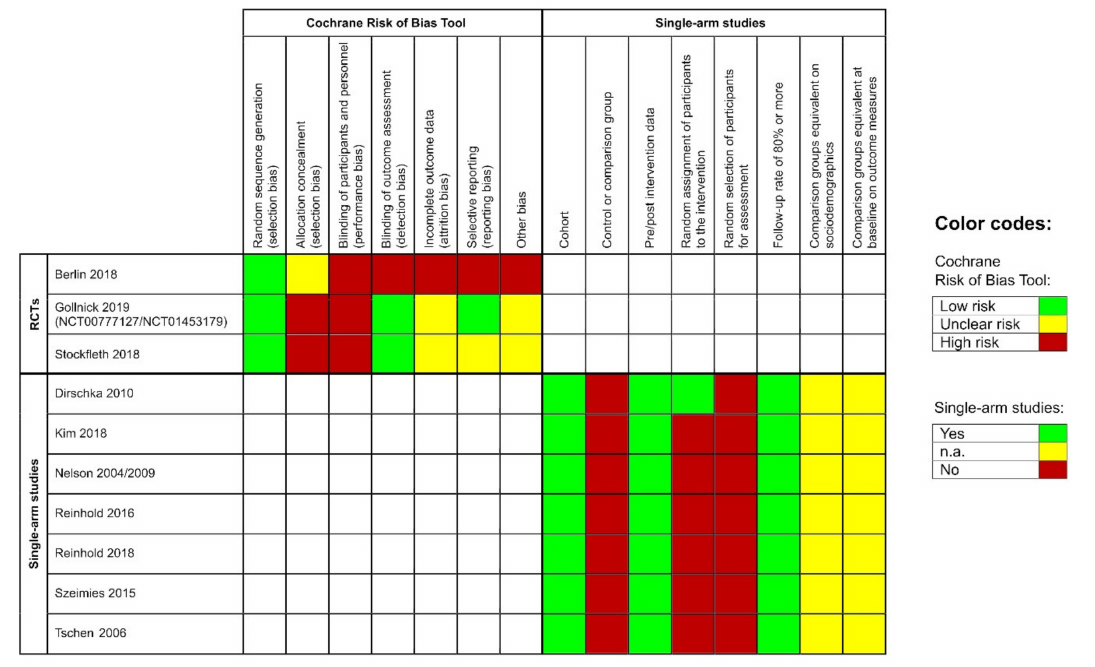
Figure 2. Left side: risk of bias evaluation for each included randomized controlled pivotal trial (RCT); risk of bias summary: review authors’ judgements about each risk of bias item for each included study: ‘ + ’ = low risk, ‘-’ = high risk, ‘?’ = unclear risk of bias. Right side: risk of bias evaluation of the single-arm studies according to the Evidence Project; n.a. = not